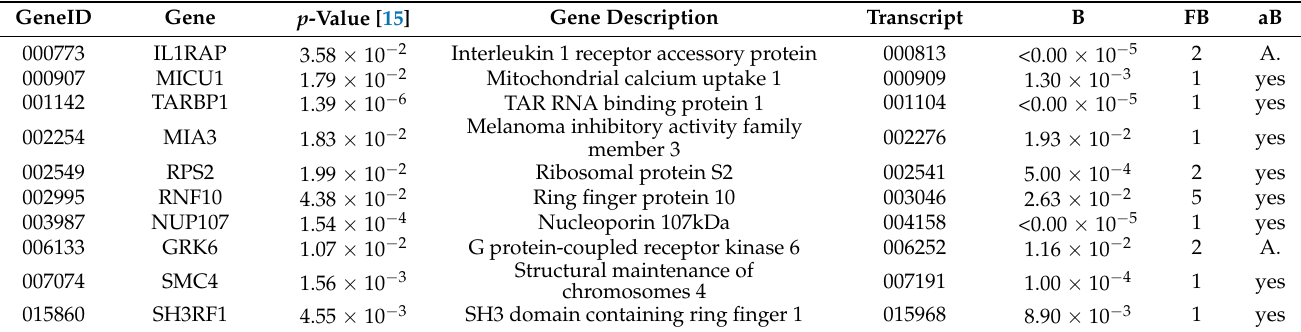
Table 4. Summary of the positive selection analysis for high-altitude candidate genes of a toad-headed agama ( Phrynocephalus vlangalii ) [15] tested likewise positive in Asymblepharus (A) using BUSTED (B); p -value > 0.05) [55], FUBAR (FB; number of sites under positive selection) [56] and aBSREL (aB) [57,58] methods. PSGs are represented by the last six digits of the anole lizard’s ( Anolis carolinensis ) ENSEMBL gene and transcript identifiers (starting with ENSACAG00000, or ENSACAT00000, respectively).